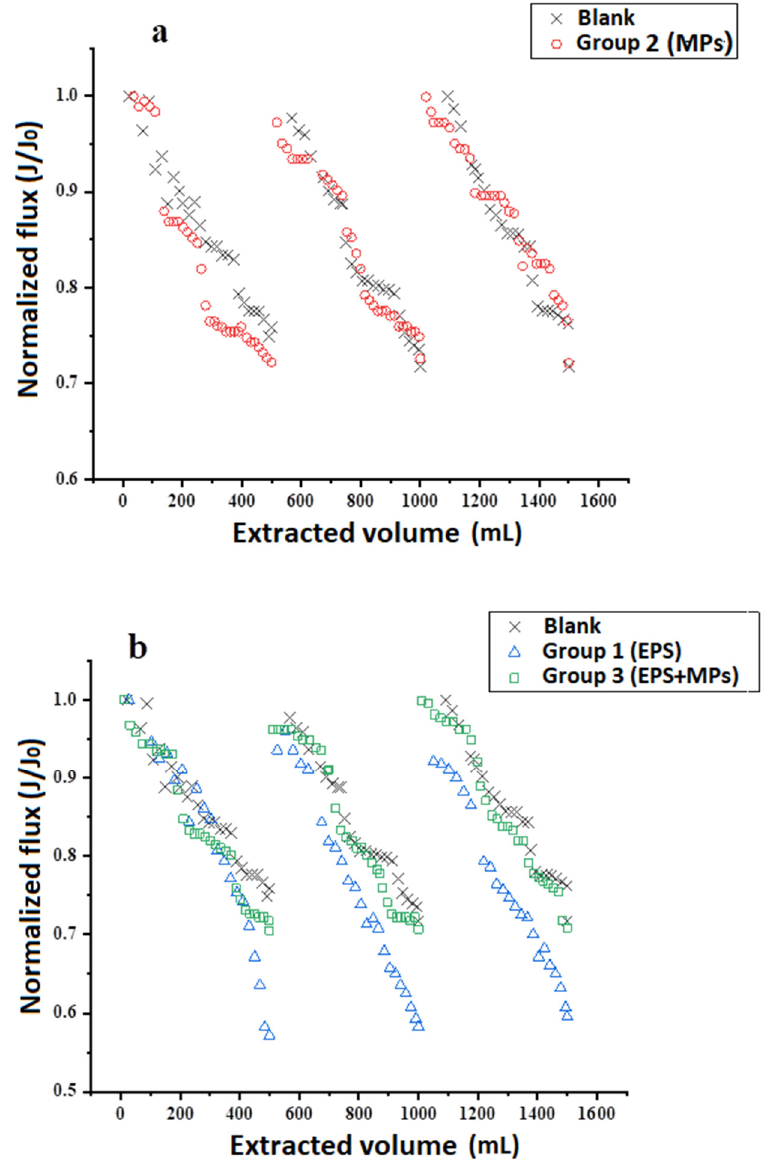
Figure 5. The comparison of normalized fluxes as a function of time between blank control and feed solution with only MPs and NPs ( a ), and between blank control, feed solution with extracellular polymers and feed solution with both extracellular polymers and plastics ( b ).